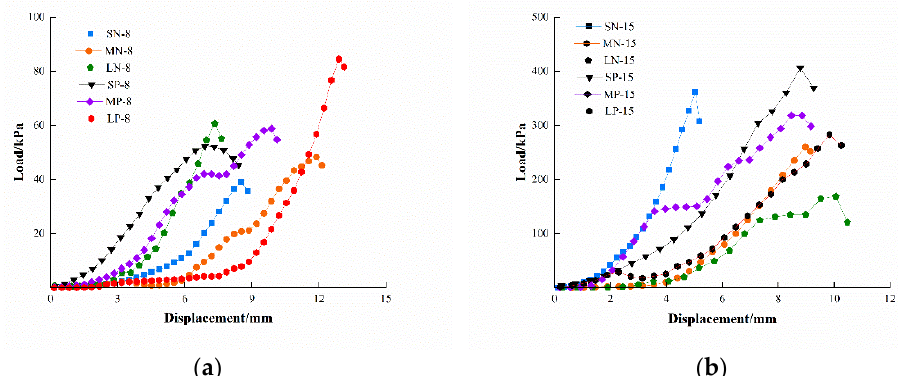
Figure 16. Load-displacement curves of grided hard crust of ( a ) 8% cement content and ( b ) 15% cement content.